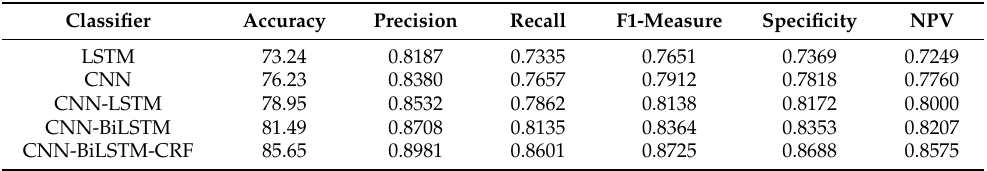
Table 5. The mean classification performance metrics with a 10-fold cross-validation technique across all participants in Experiment 1. Ten test runs were performed on each model, and the average of the results was calculated.